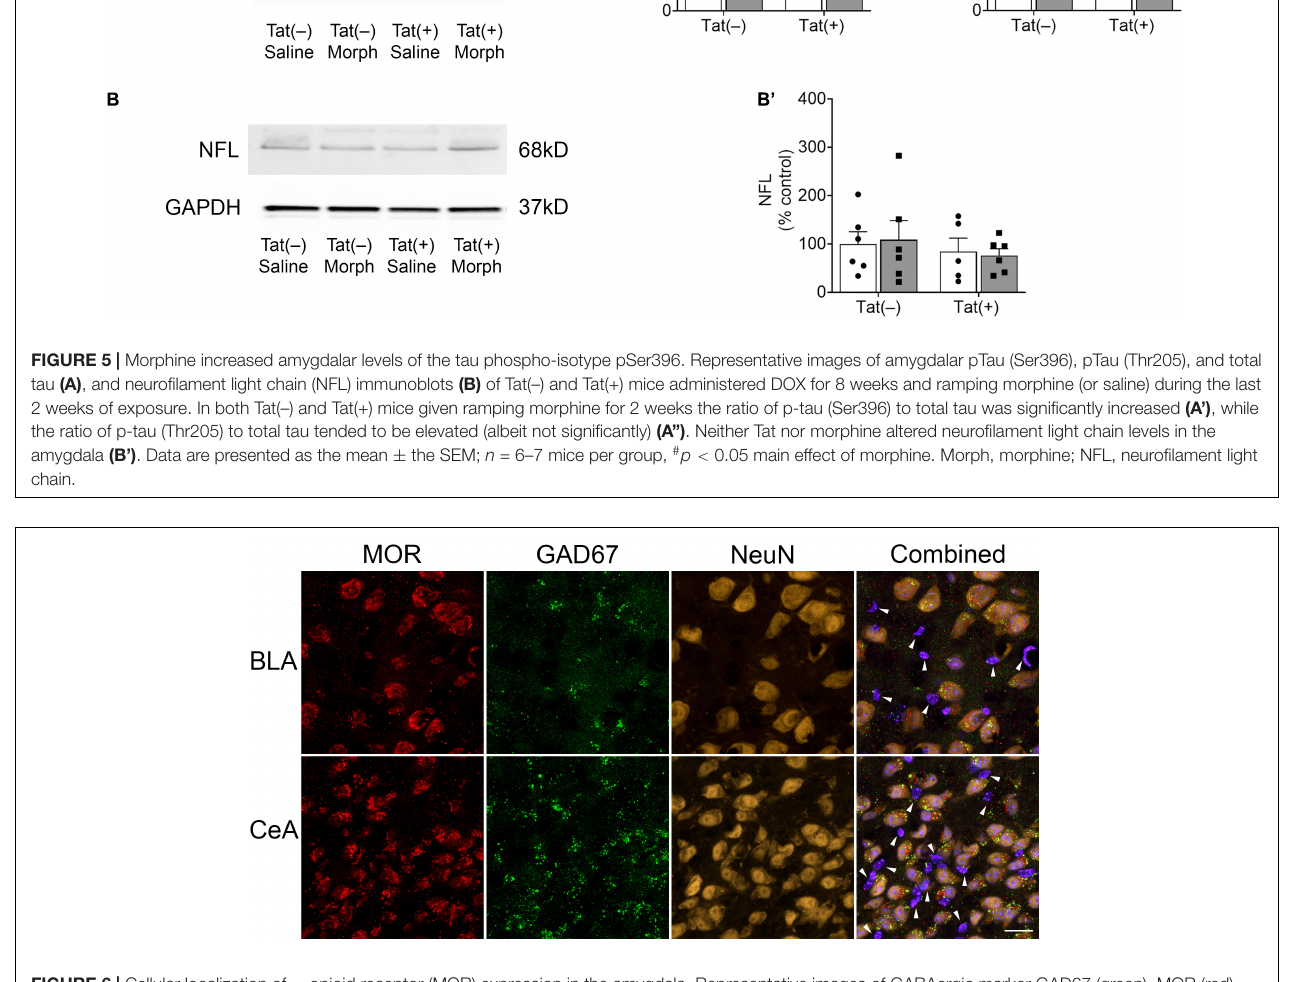
FIGURE 6 | Cellular localization of µ -opioid receptor (MOR) expression in the amygdala. Representative images of GABAergic marker GAD67 (green), MOR (red), neuronal marker NeuN (yellow-orange), and Hoechst (violet-blue) positive cells were taken using a Zeiss LSM 700 microscope at 63 × magnification (Zeiss, Oberkochen, Germany). Most MOR immunoreactive-cells in the basolateral amygdala (BLA) and central nucleus of the amygdala (CeA) were positive for GAD67 and NeuN, suggesting MOR is predominately located on GABAergic neurons within these amygdalar nuclei. However, (as indicated by the white arrows) some MOR immunoreactive-cells did not colocalized with GAD67 nor NeuN. Scale bar = 20 µ